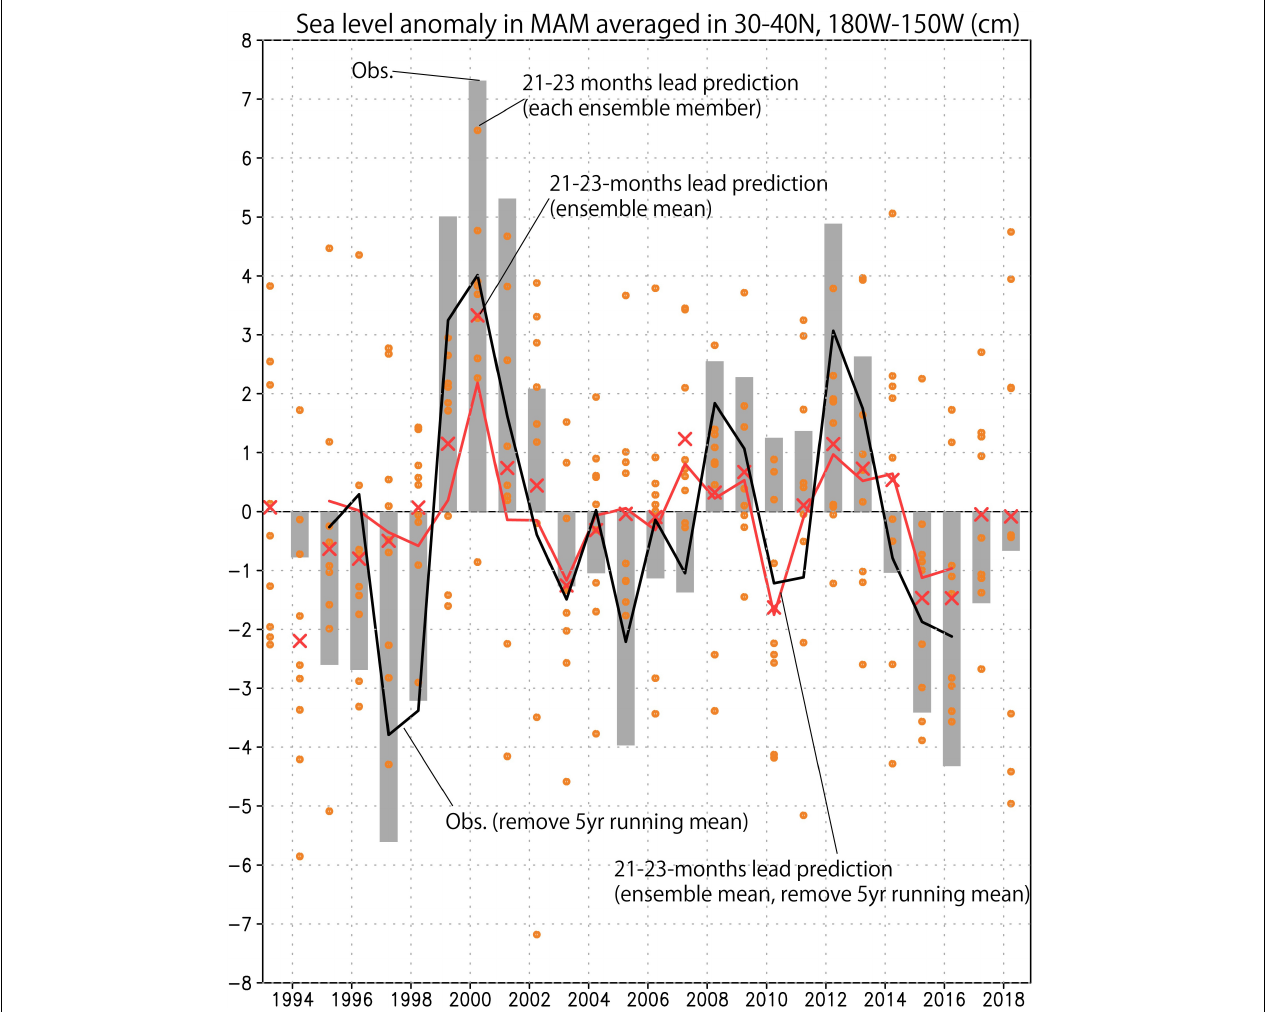
FIGURE 2 | Time series of sea level anomaly averaged over 30 ◦ –40 ◦ N, 180 ◦ –150 ◦ W during March-April-May (cm). Gray column: observation, Red cross: ensemble mean prediction issued on June 1, 2-year before (21–23 months lead average), orange dot: each ensemble member prediction, black line: observation after removing 5-years running mean, red line: ensemble mean prediction after removing 5-years running